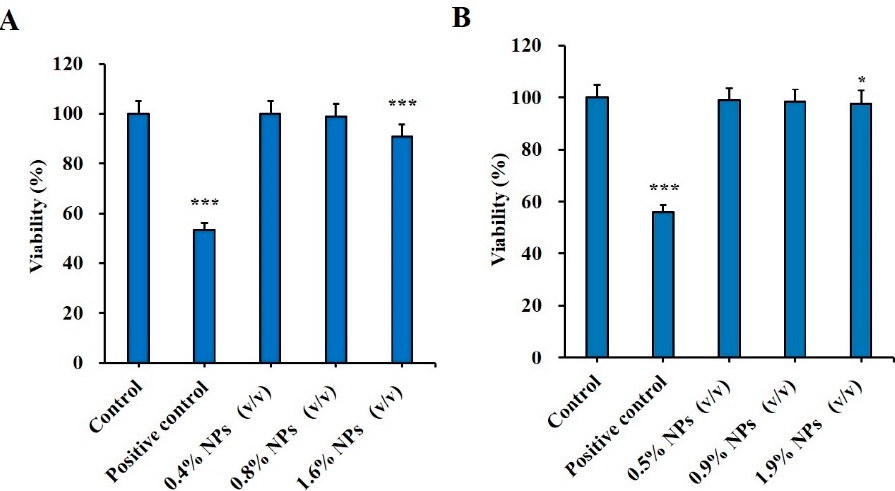
Figure 10. Cytotoxic effect of Man-BSA-CS-NPs on ( A ) HNEpC cells at a concentration of 0.4–1.6% ( v / v ) and on ( B ) DC2.4 at a concentration of 0.5–1.9% ( v / v ); 15% ( v / v ) dimethyl sulfoxide (DMSO) were taken as a positive control; cells that did not undergo any treatment were used as a negative control. Relative cell viability levels were determined by MTT assay (mean ± SD, n = 3, * p < 0.05, *** p < 0.001 compared with the control).